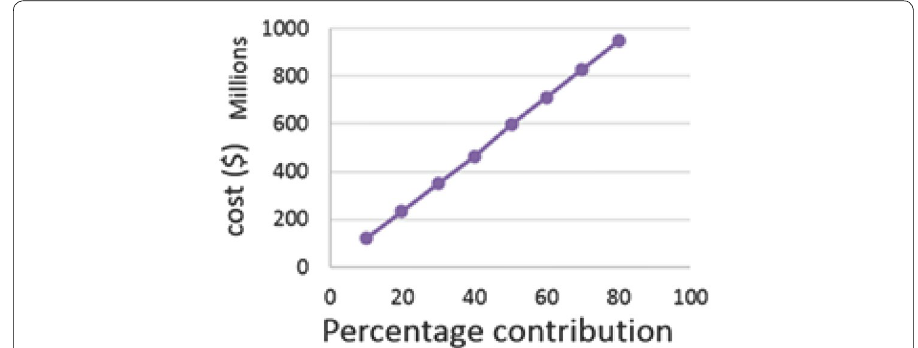
Fig. 9 Cost versus percentage contribution of geothermal energy to the total energy demand